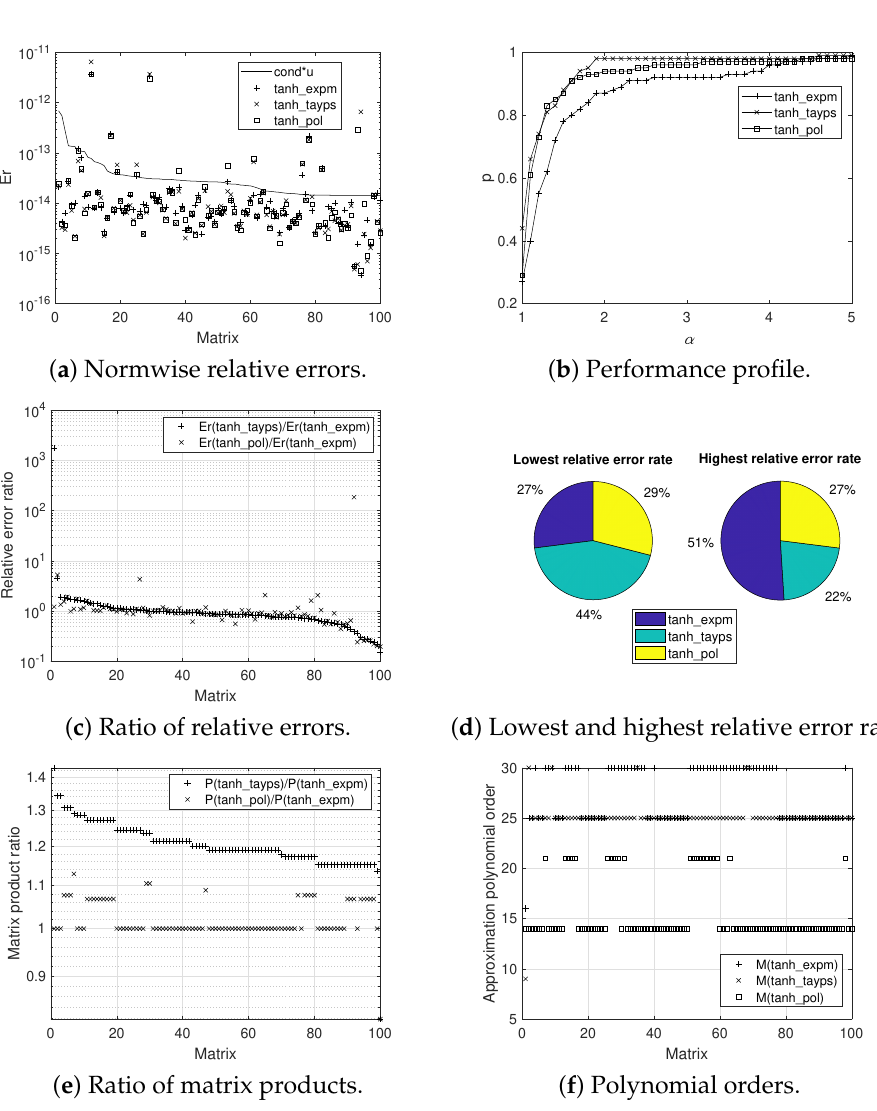
Figure 1. Experimental results for Test